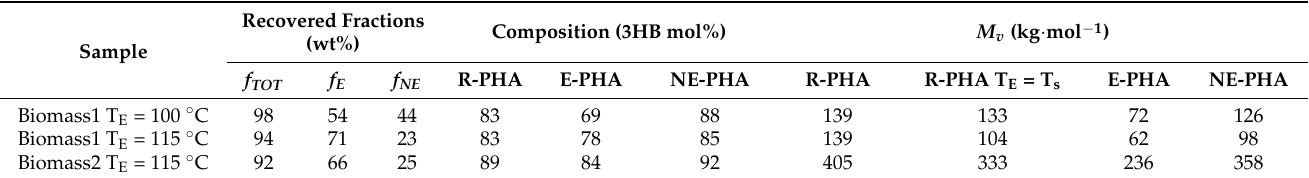
Table 3. Summary of recovered fractions ( f TOT , f E , f NE ), chemical composition and molecular weight of extracted and non-extracted PHA from Biomass1 and Biomass2 with